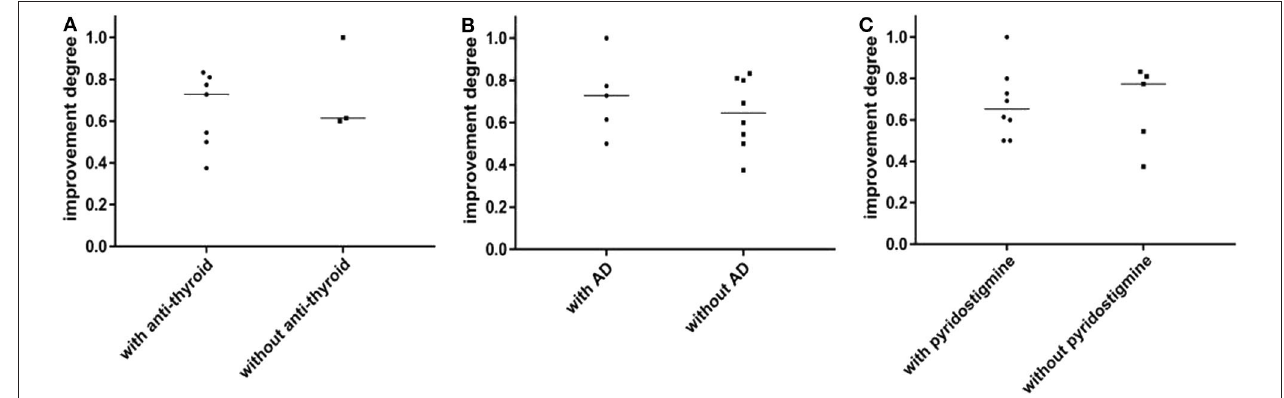
FIGURE 4 | (A) The prognosis between MuSK-MG with thyroid antibodies and without thyroid antibodies has no significant difference. (B) The prognosis between MuSK-MG patients coexist with other autoimmune disease and without other autoimmune disease has no statistical difference. (C) There was no statistical difference in the prognosis between MuSK-MG patients who were treated with pyridostigmine bromide and those who were not. Comparison between groups was done by Mann-Whitney test. P < 0.05 indicated a statistically significant